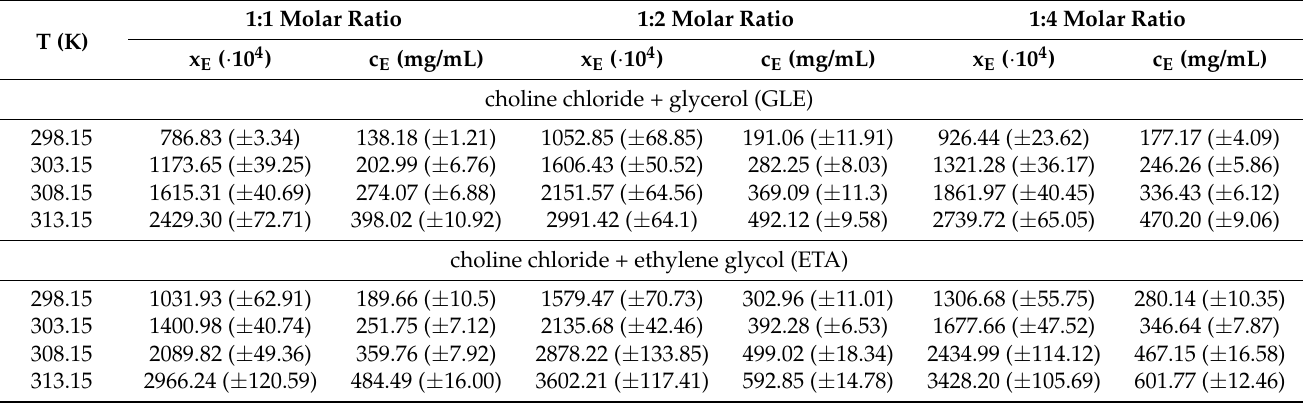
Table 1. The solubility of edaravone dissolved in DES in different molar ratios (choline chloride first) at various temperatures. Values expressed as mole fractions (x E , 10 4 ) and concentrations (c E , mg/mL). Standard deviation values are given in